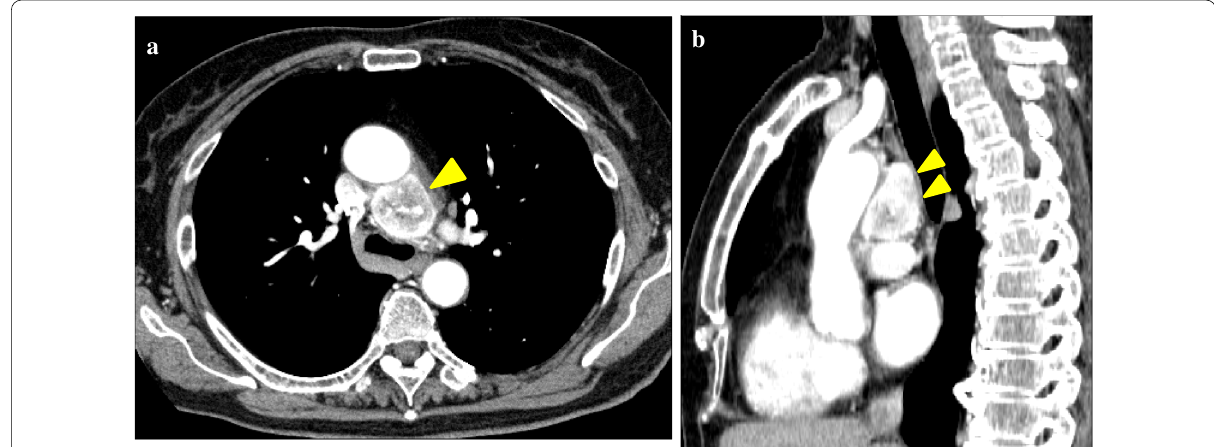
Fig. 1 Chest CT scan. Preoperative contrast-enhanced chest computed tomography scan showing a ring-enhancing tumor in the middle mediastinum